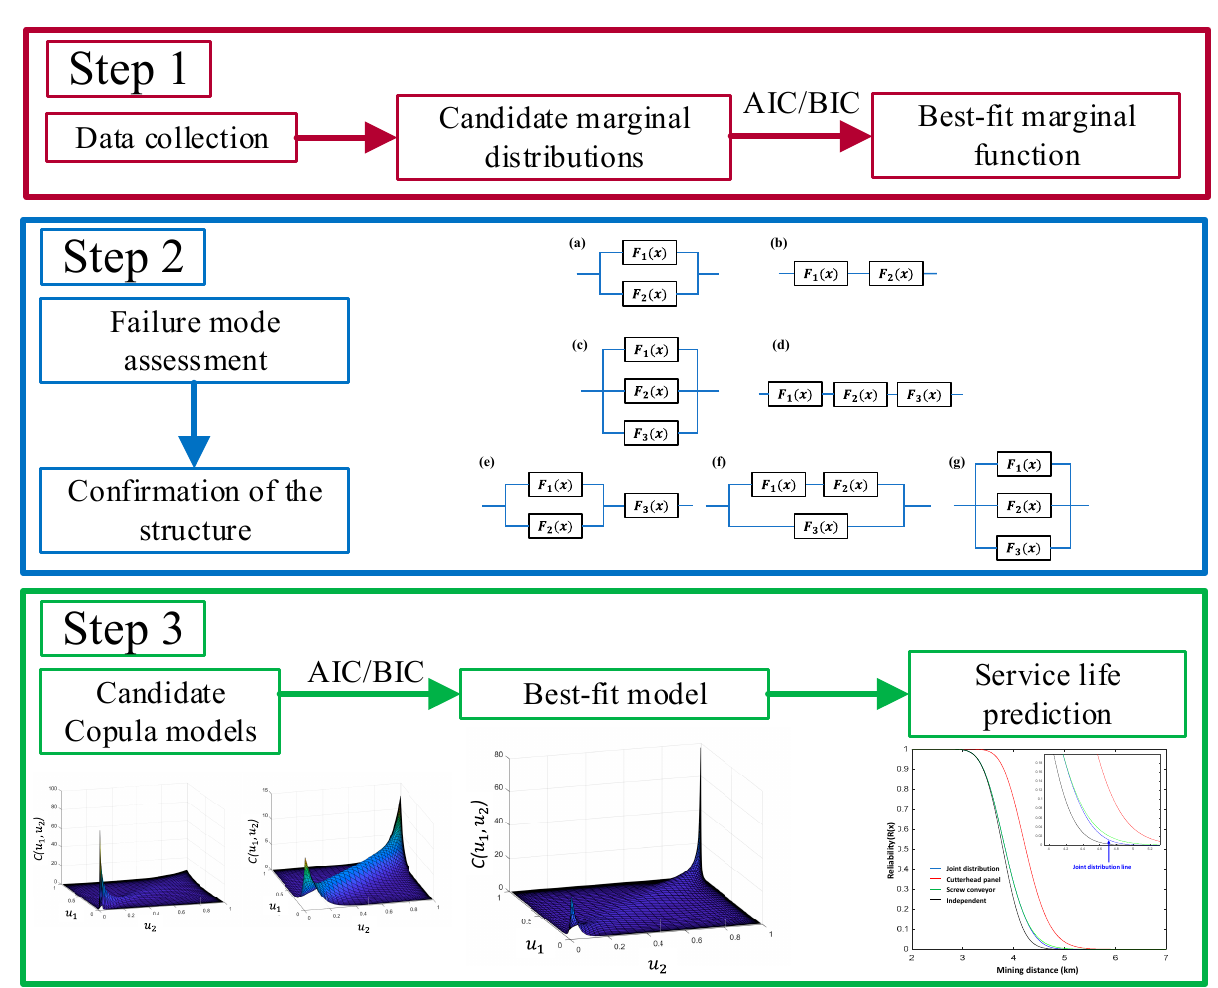
Figure 1. Flowchart of the developed approach for reliability assessment in complex systems.